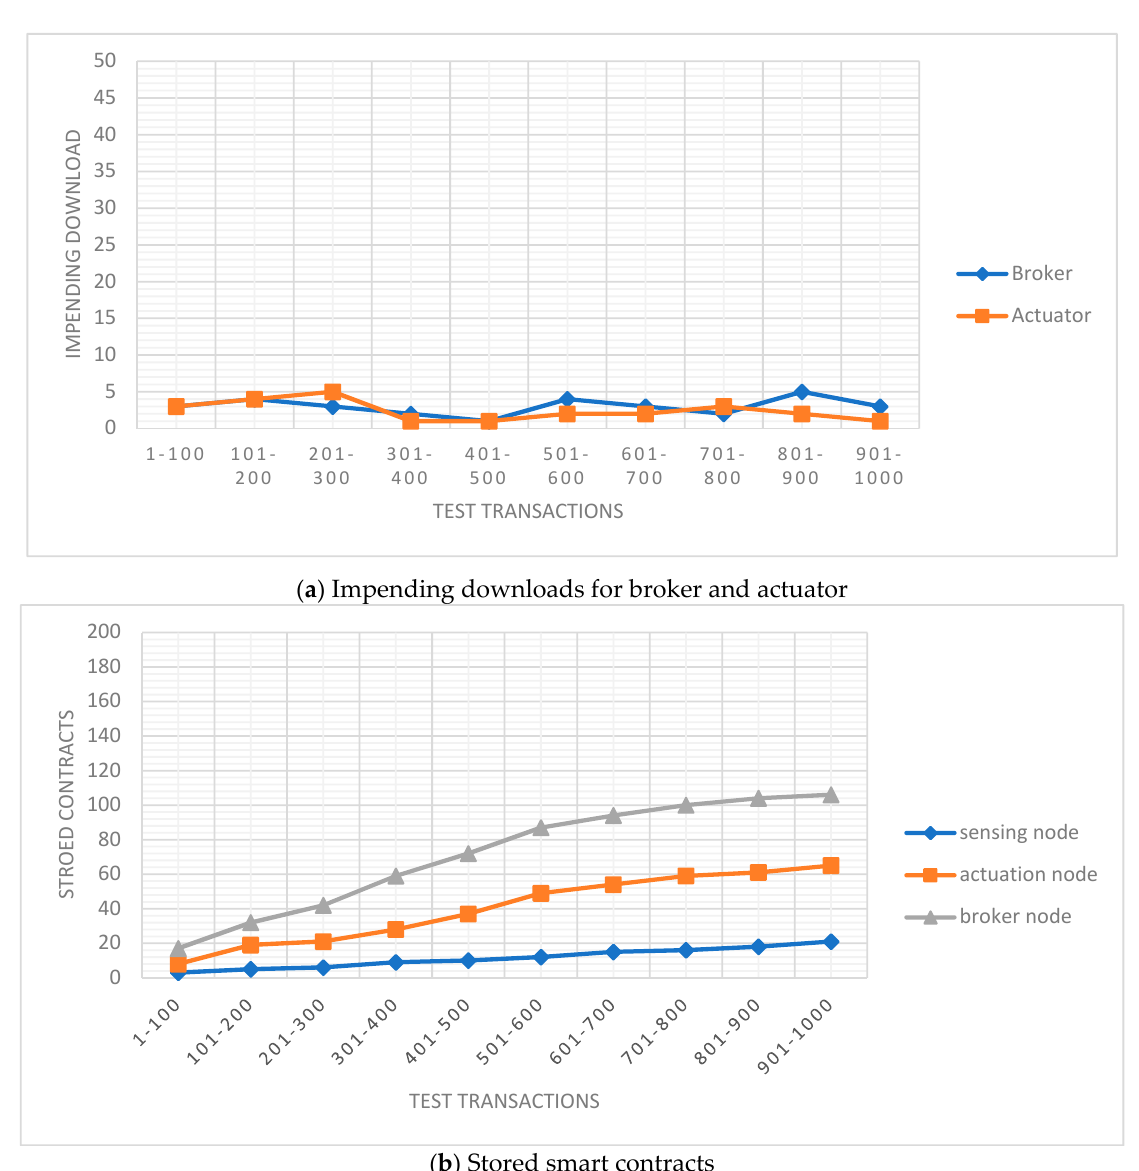
Figure 9. Performance of proposed GNN node classification in lightweight IoT blockchain network.